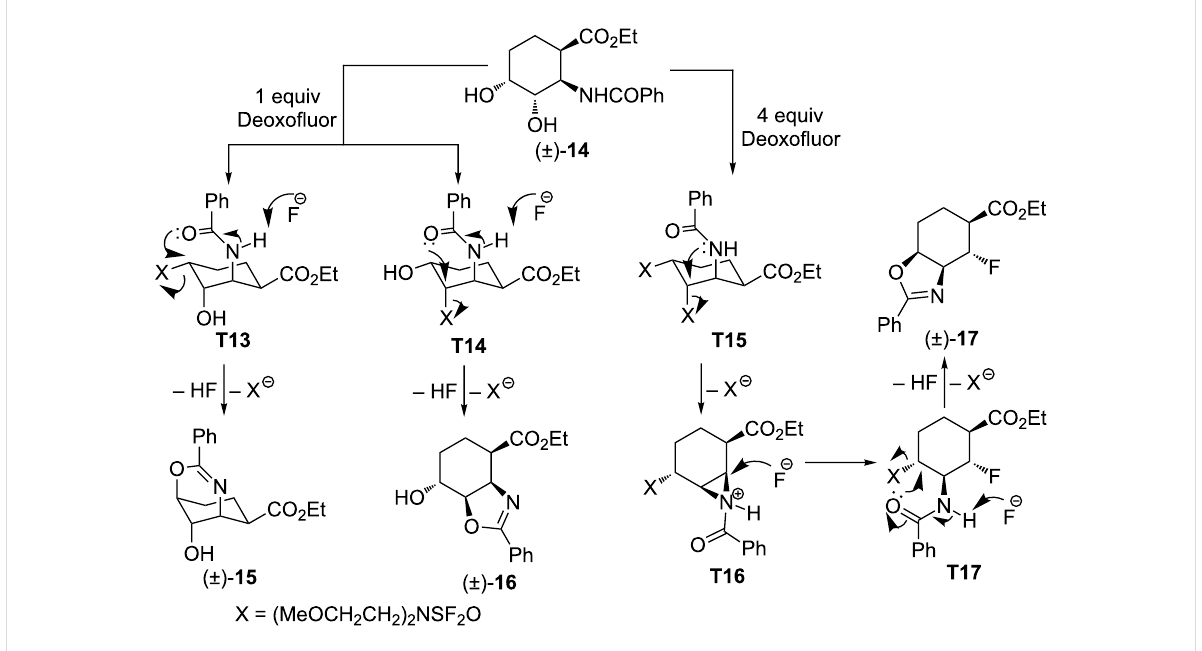
Scheme 8: Proposed route for the formation of compounds (±)- 15 , (±)- 16 and (±)- 17